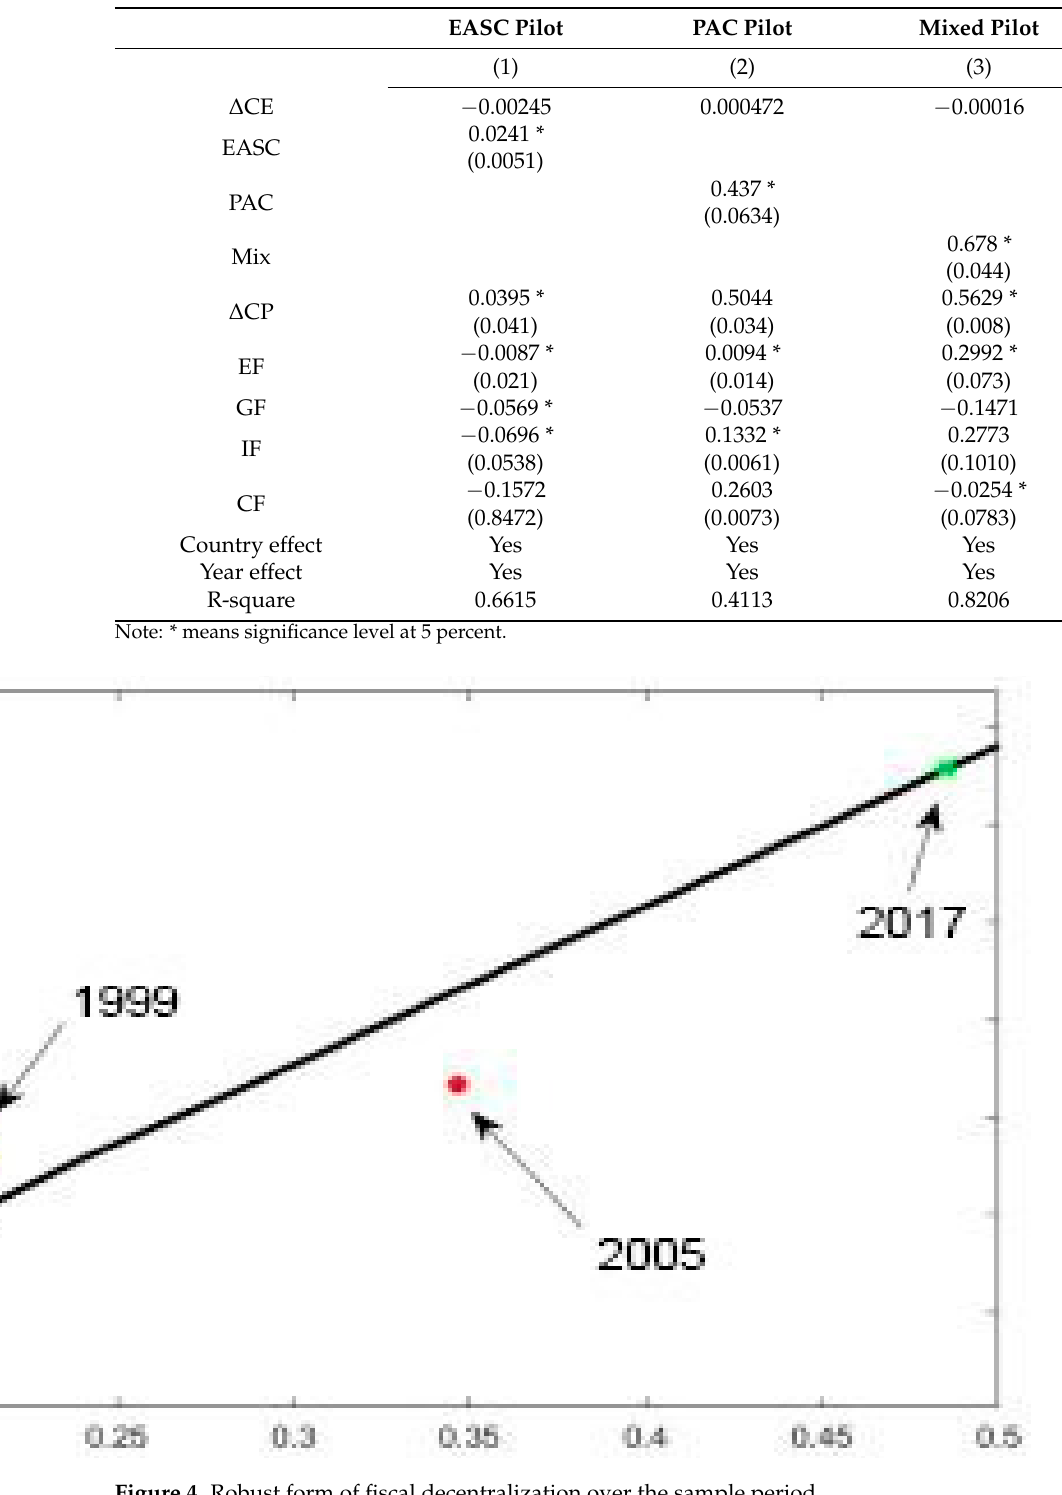
Figure 4. Robust form of fiscal decentralization over the sample period.